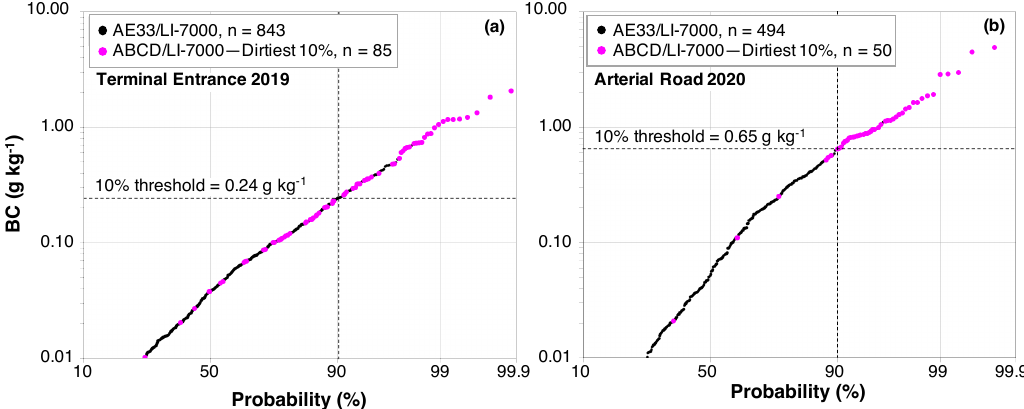
Figure 4. Probability distributions of emission factors determined with the AE33 / LI-7000 for the ( a ) Terminal Entrance and ( b ) Arterial Road fleets (black dots). The dashed lines indicate the AE33 / LI-7000 threshold for classifying the dirtiest 10% of the fleet as high emitters, those located in the upper right quadrant. The high-emitting trucks identified by the ABCD / LI-7000 are highlighted on these distributions (fuchsia dots). Note that these superimposed points are AE33 / LI-7000 emission factor values for high-emitting trucks (dirtiest 10%) according to the ABCD /